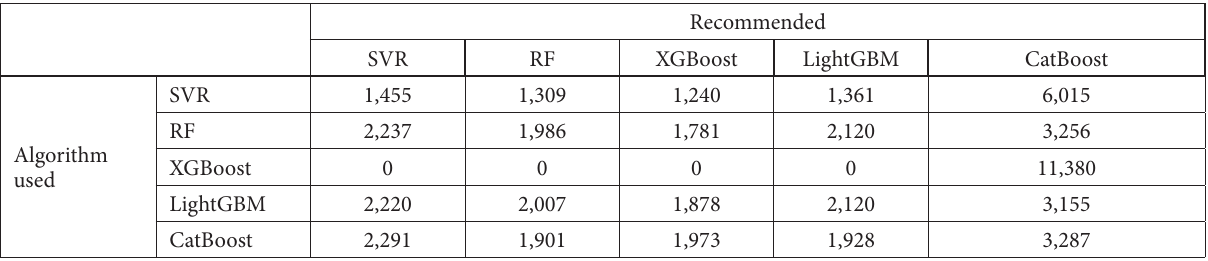
Table 9. Number of recommendations in machine learning (ML)-based voting (N = 11,380)